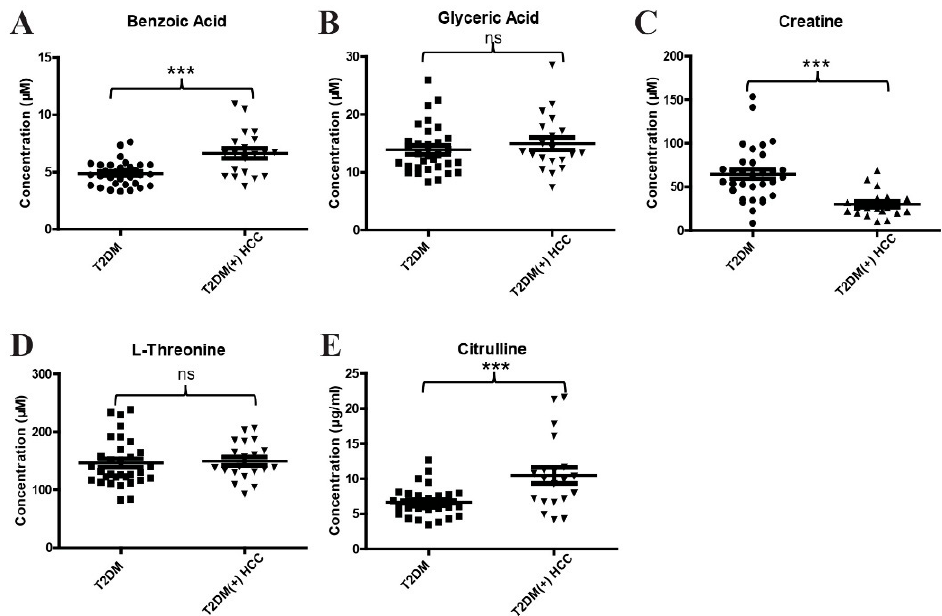
Figure 4. The expression profiles of several dysregulated metabolites in the discovery cohort. ( A ) The levels of serum benzoic acid in the discovery cohort. ( B ) The levels of serum glyceric acid in the discovery cohort. ( C ) The levels of serum creatine in the discovery cohort. ( D ) The levels of serum L-threonine in the discovery cohort. ( E ) The levels of serum citrulline in the discovery cohort. *** p value < 0.001; ns, not significant.